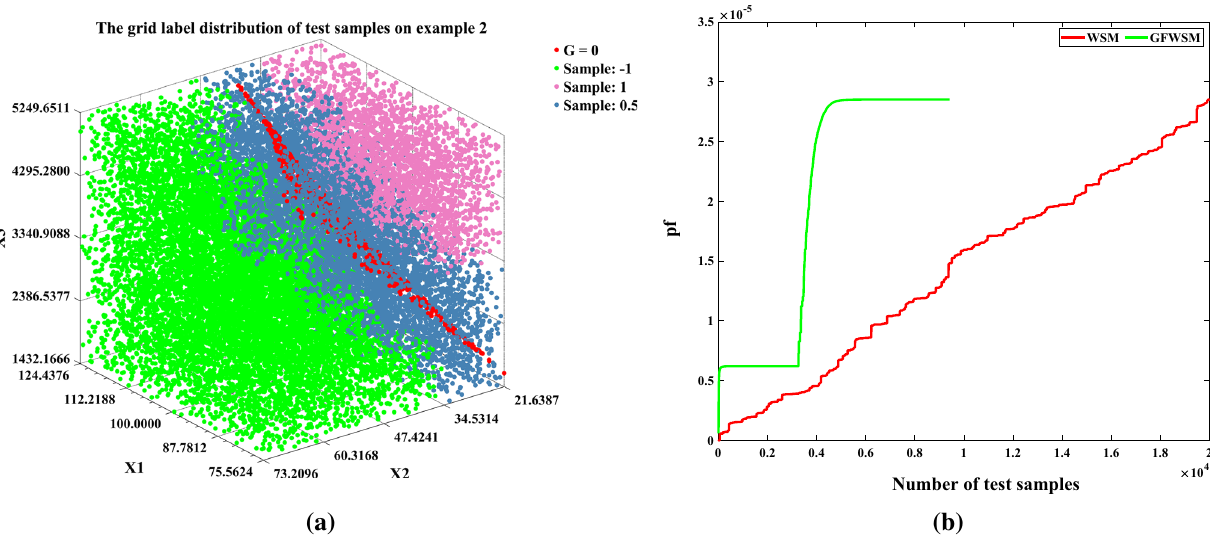
Fig. 5 Simulation results on reliability analysis example 2: a the grid label distribution of test samples in GFWSM, b convergence process of failure probability of WSM and GFWSM